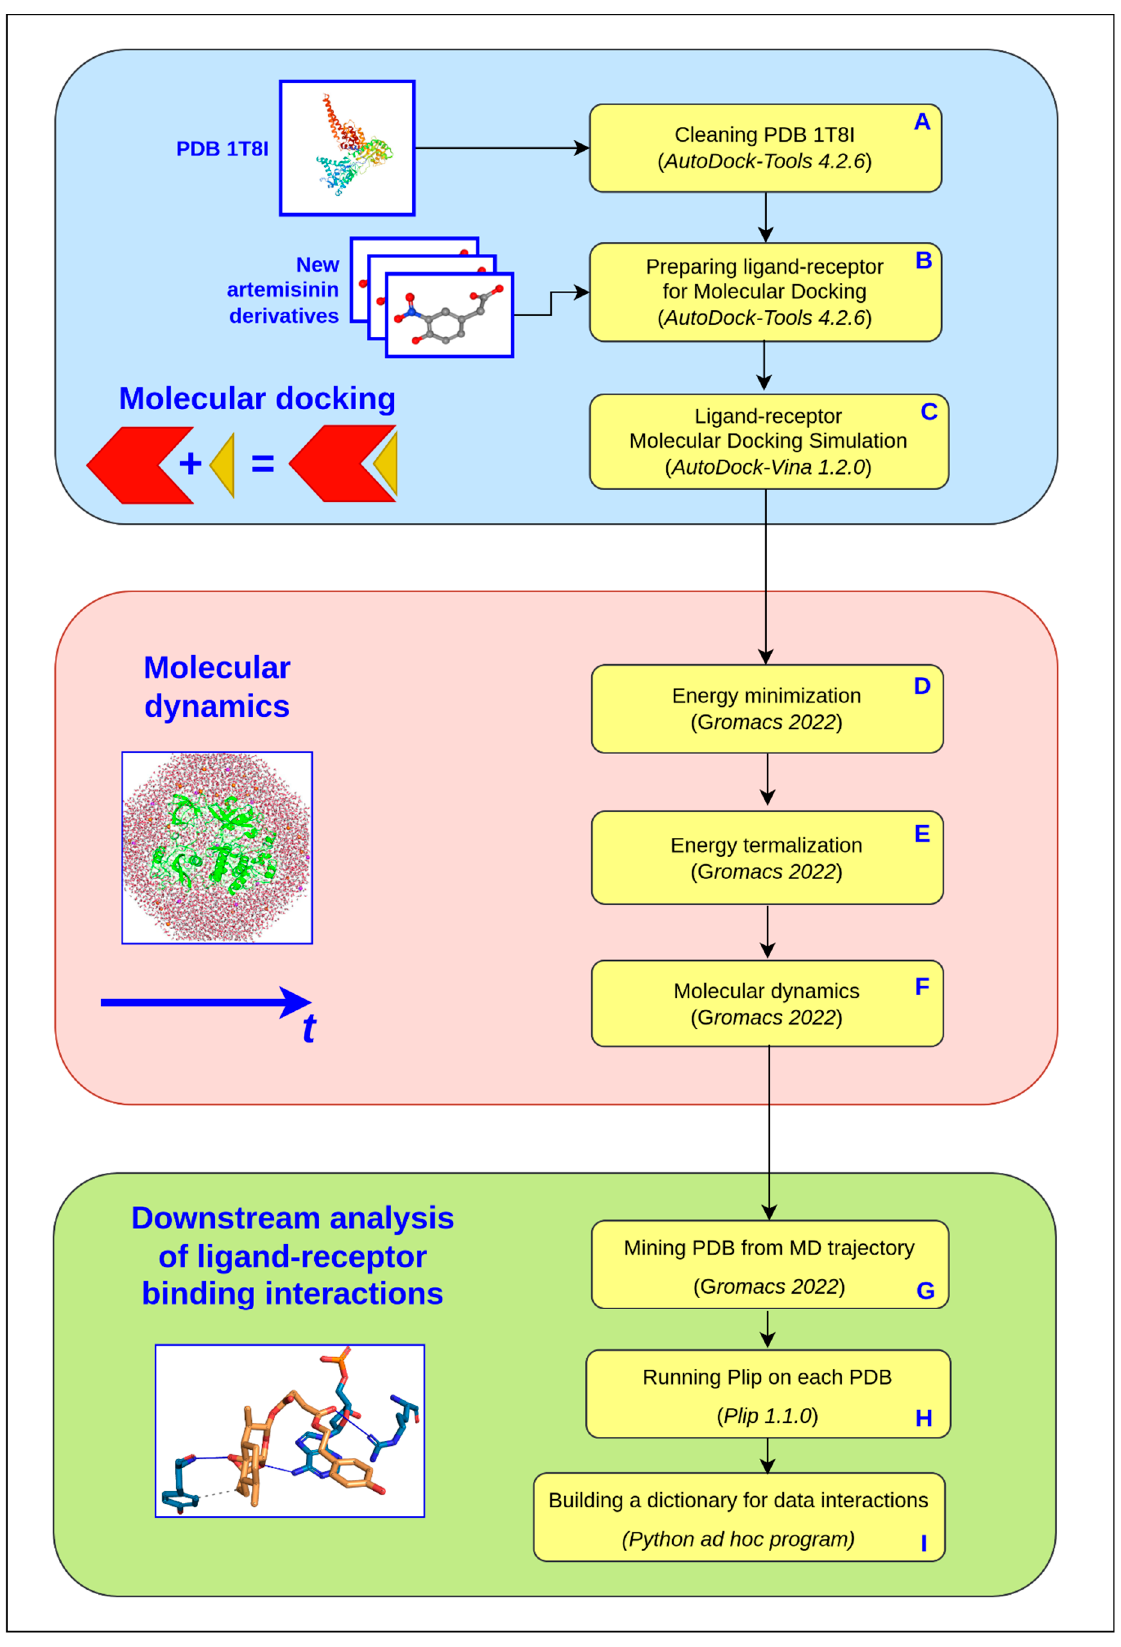
Figure 2. The protocol workflow implemented for the molecular docking simulation, the molecular dynamics simulation and the downstream analysis. In detail: the first phase involves molecular docking simulations (steps A–C) using Autodock Tools and Autodock Vina. This phase involves: